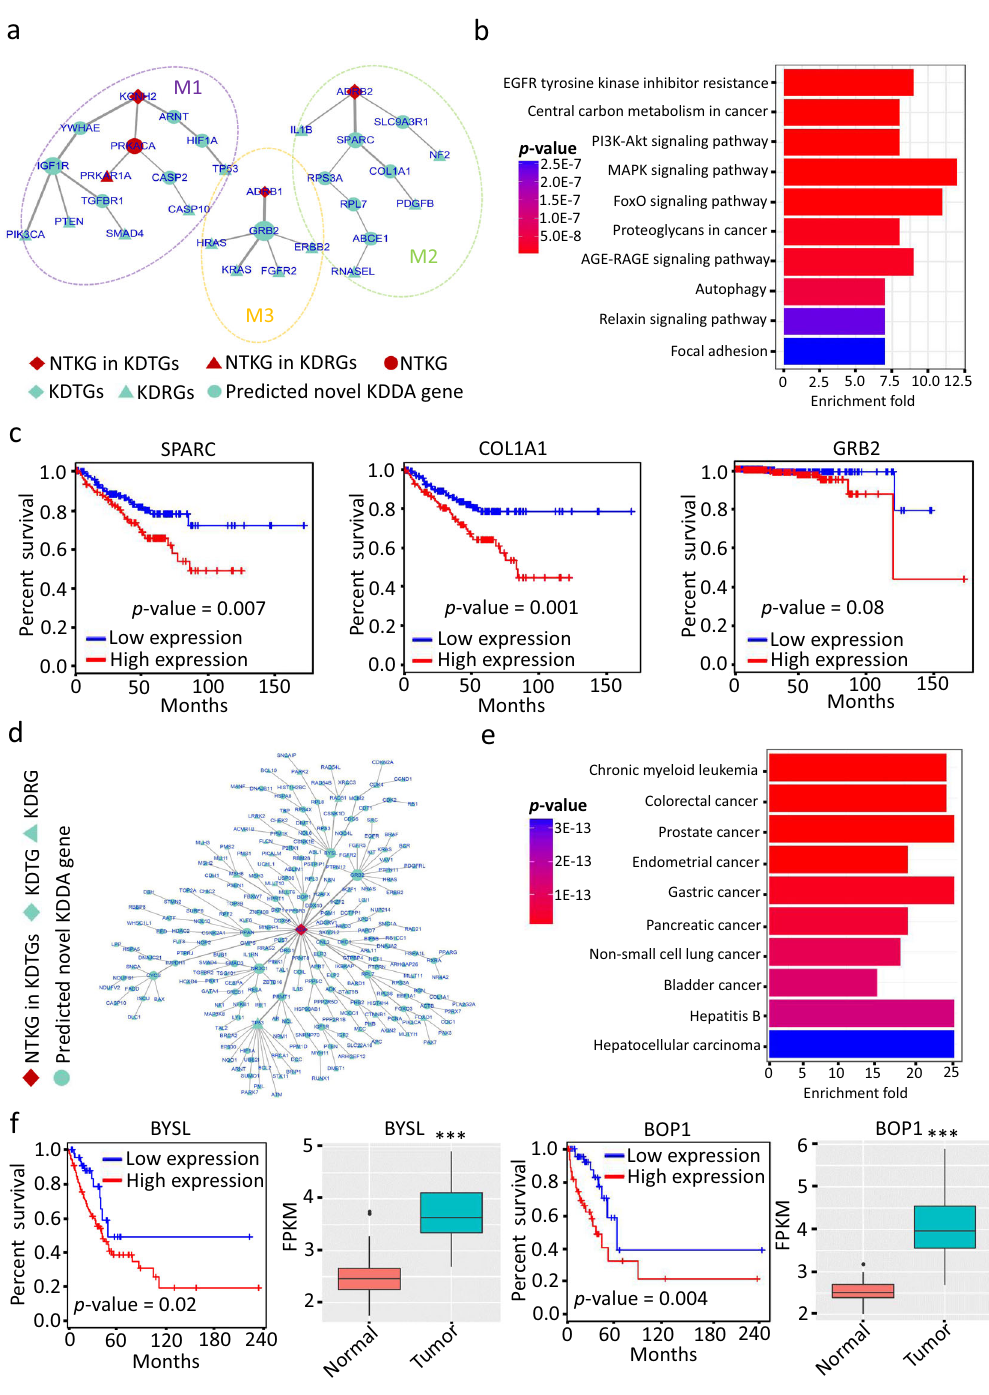
Fig. 4 KDDANet provided novel molecular insights on KDDAs related to cancer. a KDDANet resulting subnetwork mediating sotalol (DB00489)-prostate cancer (176807) association. b Top ten enriched KEGG terms of subnetwork genes mediating sotalol-prostate cancer association. c Gene expression-based survival analysis for CASP2, SPARC, and GRB2 in patients with prostate cancer, obtained by GEPIA online analysis (http://gepia.cancer-pku.cn/about.html). d KDDANet gene subnetwork mediating nebularine (DB04440)-lung cancer (211980) association. e Top ten enriched KEGG terms of subnetwork genes mediating nebularine-lung cancer association. f Gene expression-based survival analysis for BYSL and BOP1 in patients with TCGA LUAD lung cancer obtained by GEPIA online analysis (http://gepia.cancer-pku.cn/ about.html) and their expression levels in lung cancer tumor samples and adjacent normal tissue samples, *** p value < 0.001, calculated by Wilcox signed rank test. In the subnetworks, the size of a gene node was proportional to its network degree; the thickness of a network edge was proportional to its fl ow